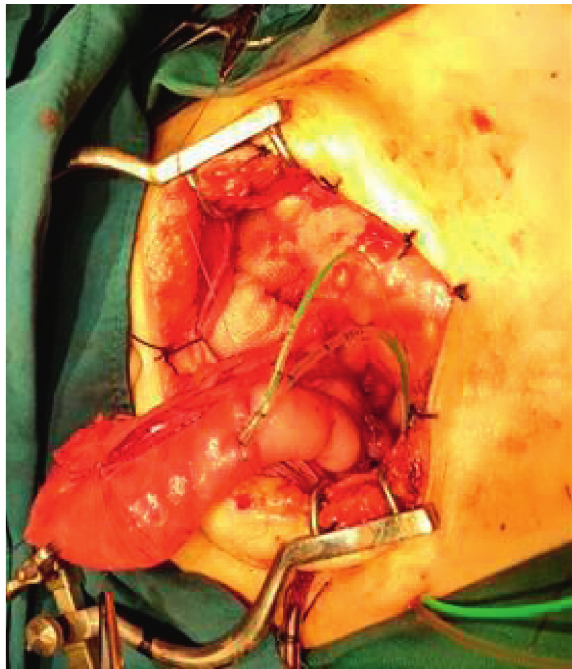
Figure 3: Neobladder creation surgery using the cecum and a part of the ascending